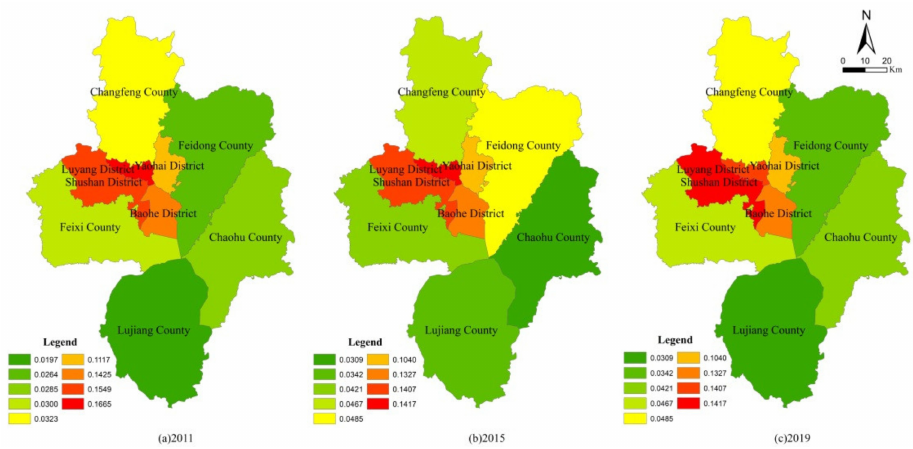
Figure 6. Living function evaluation results of districts and counties under carbon